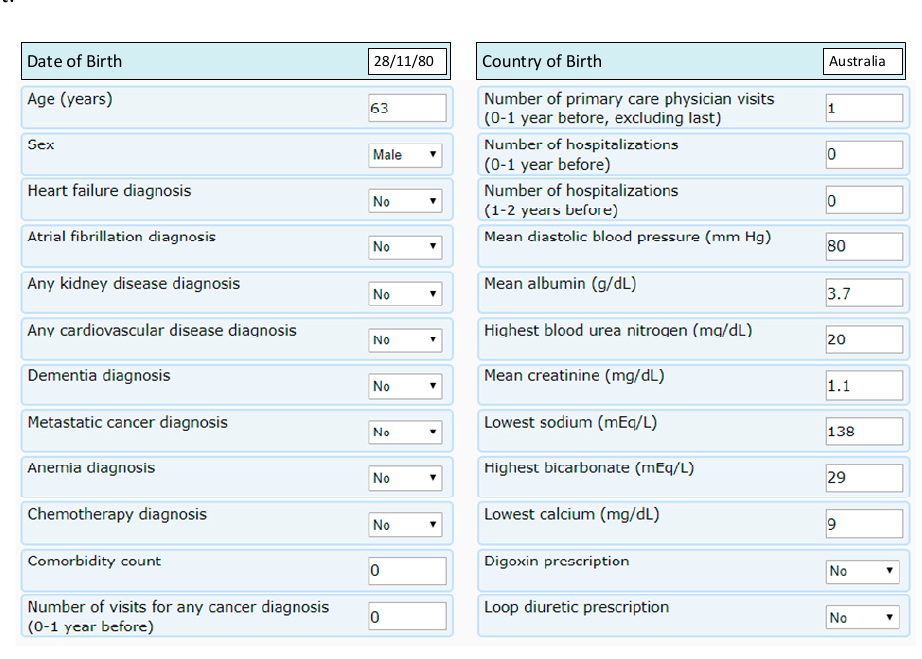
Figure 2. Questionnaires for five-year survival probability. The results will estimate a given patient’s probability of surviving at least five years from the last hospital admission (Reproduced with permission from Ankit Agrawal [18]).